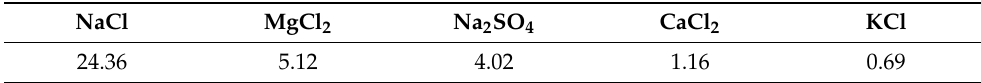
Table 3. Composition of the artificial seawater (g/L).